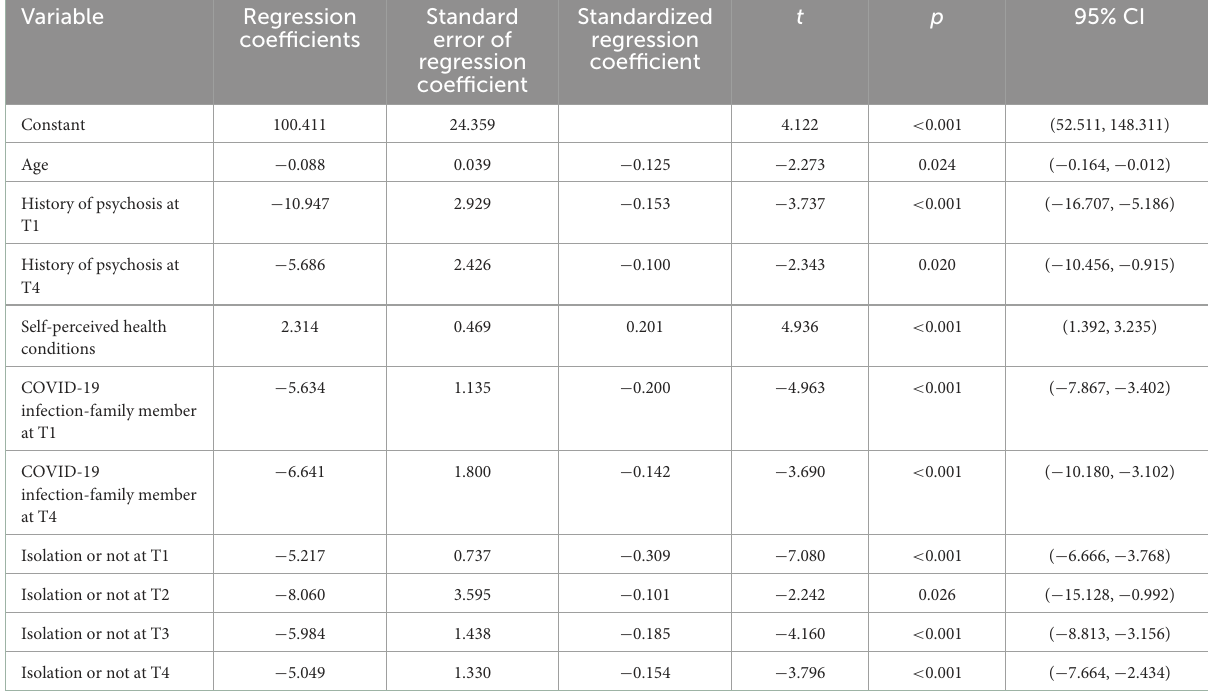
TABLE 4 Multiple linear regression analysis of influencing factors of PSS. Variable